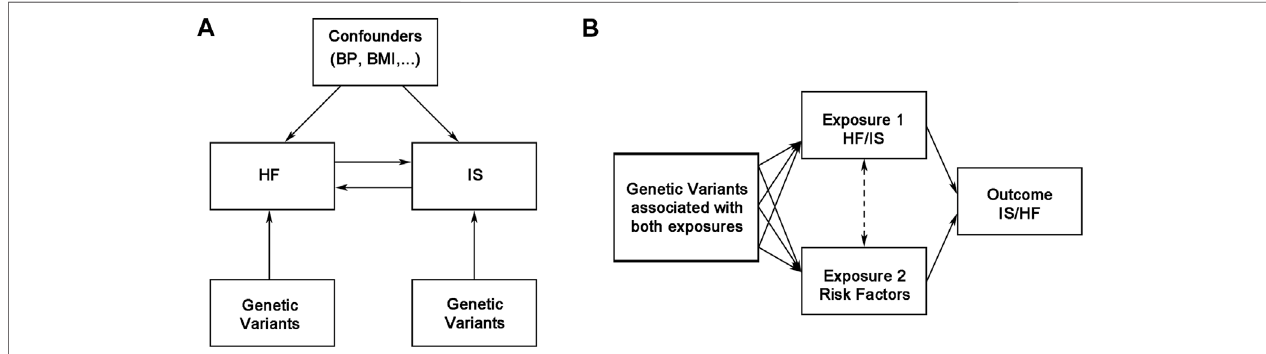
FIGURE1| Overviewofthebidirectional andmultivariableMendelianrandomizationstudydesign. BMI,bodymassindex;BP,blood pressure;HF,heartfailure;IS, ischemic stroke.